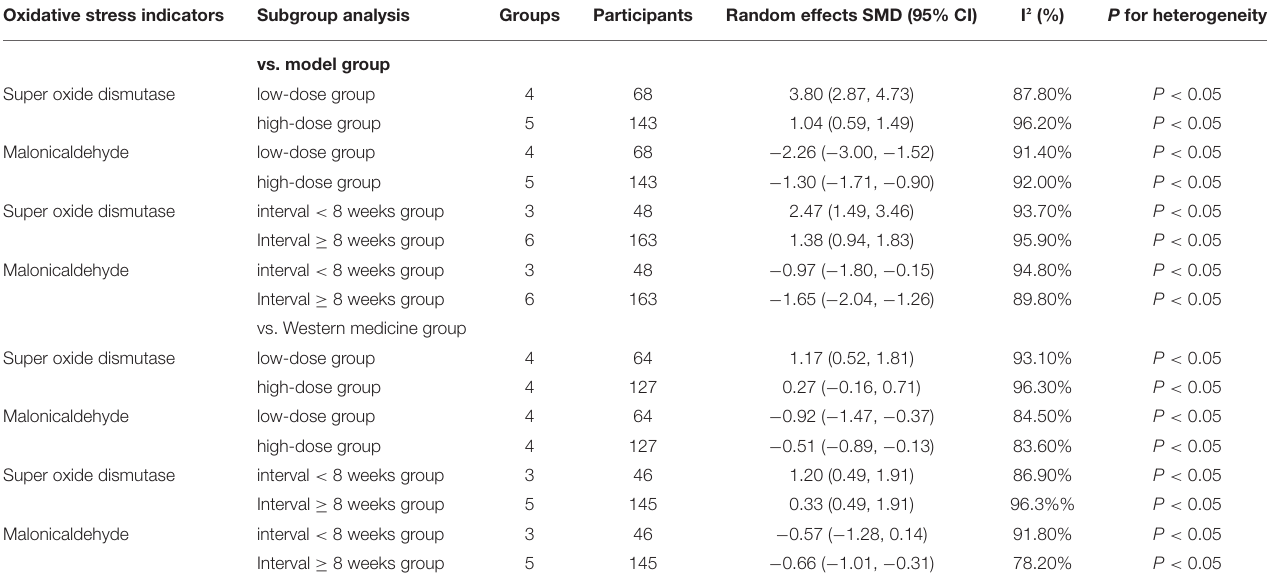
TABLE 3 | Summary of subgroup